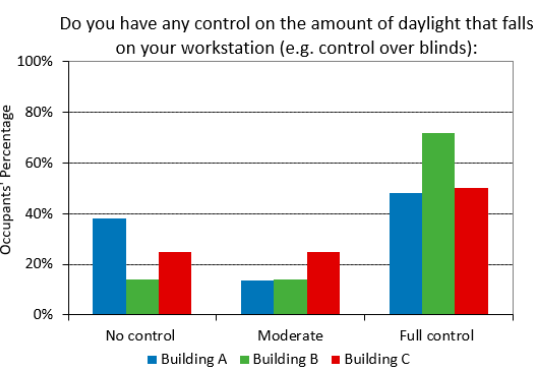
Figure 14. Preference of occupants for how satisfied they are with their degree of control ( left ) and how important is from them to control the artificial lighting of their working plane separately from the others ( right ).